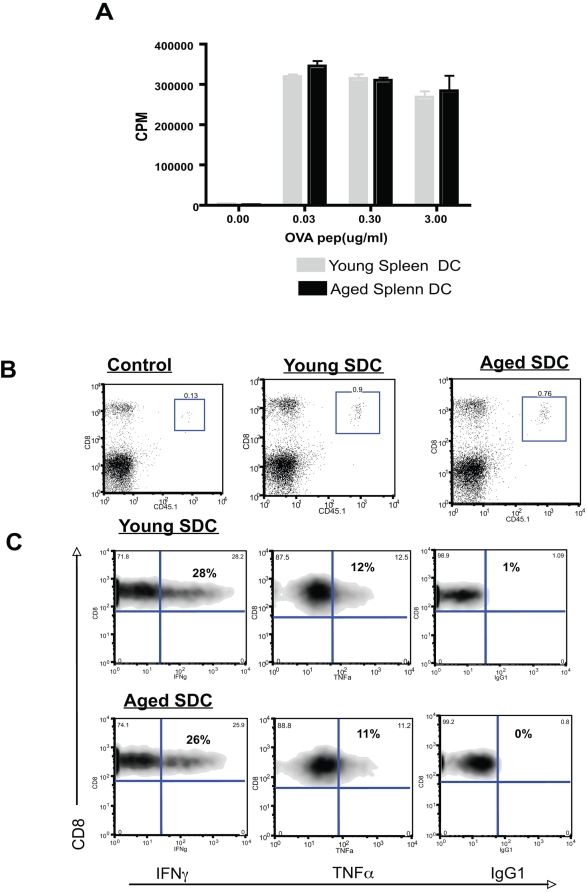
Aged splenic DCs loaded with cognate peptide exhibit a similar ability to prime antigen specific CD8+ T cells as compared to young splenic DCs.A: Aged and young splenic DCs were cultured with OTI T cells in the presence of OVA peptide and proliferation measured. Representative from one experiment, which was repeated with similar results. B: Young hosts (N = 3/group) were adoptively transferred with young CD45.1+ OTI T cells and either young or aged splenic DCs that had been pulsed with OVA peptide (or irrelevant peptide, GP33, as a control). After 5 days, expansion of transferred young OTI T cells was assessed. Proportion of transferred T cells is shown in the box in each flow plot. Representative data from one experiment, which was repeated with similar results. C: Same experiment as B except that cytokine production by the transferred OTI T cells (gated on CD45.1+ population) is measured by intracellular cytokine staining. Proportion % is shown in each flow plot.